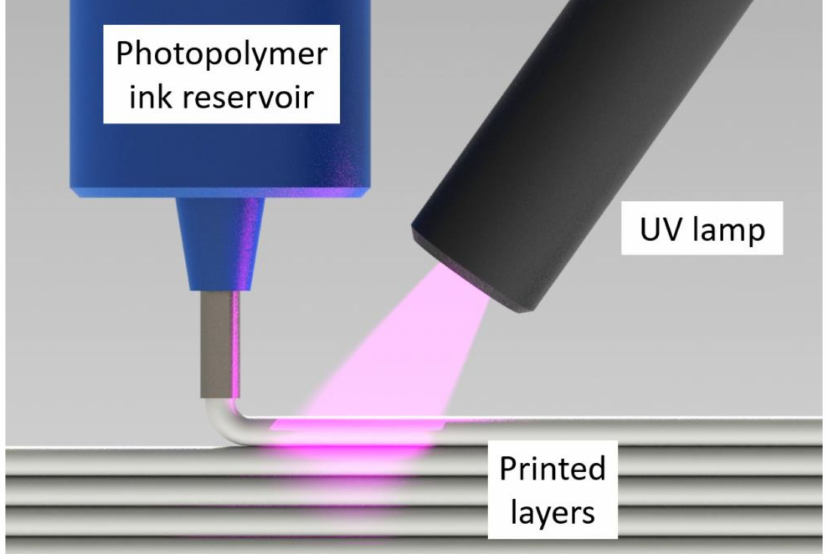
Figure 1. Schematic depicting the UV-DIW printing process, in which a photopolymer ink is deposited and rapidly cured in